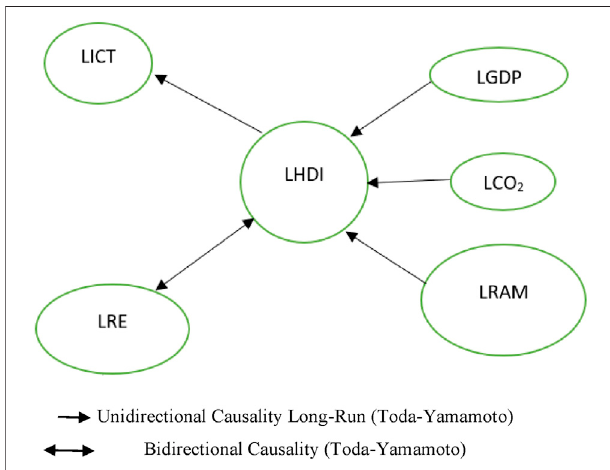
FIGURE 2 | Causality relationship. Unidirectional causality long-run (Toda – Yamamoto) and bidirectional causality (Toda – Yamamoto).